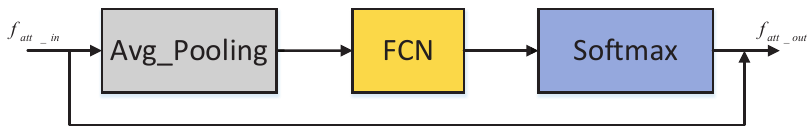
Figure 4. Attention